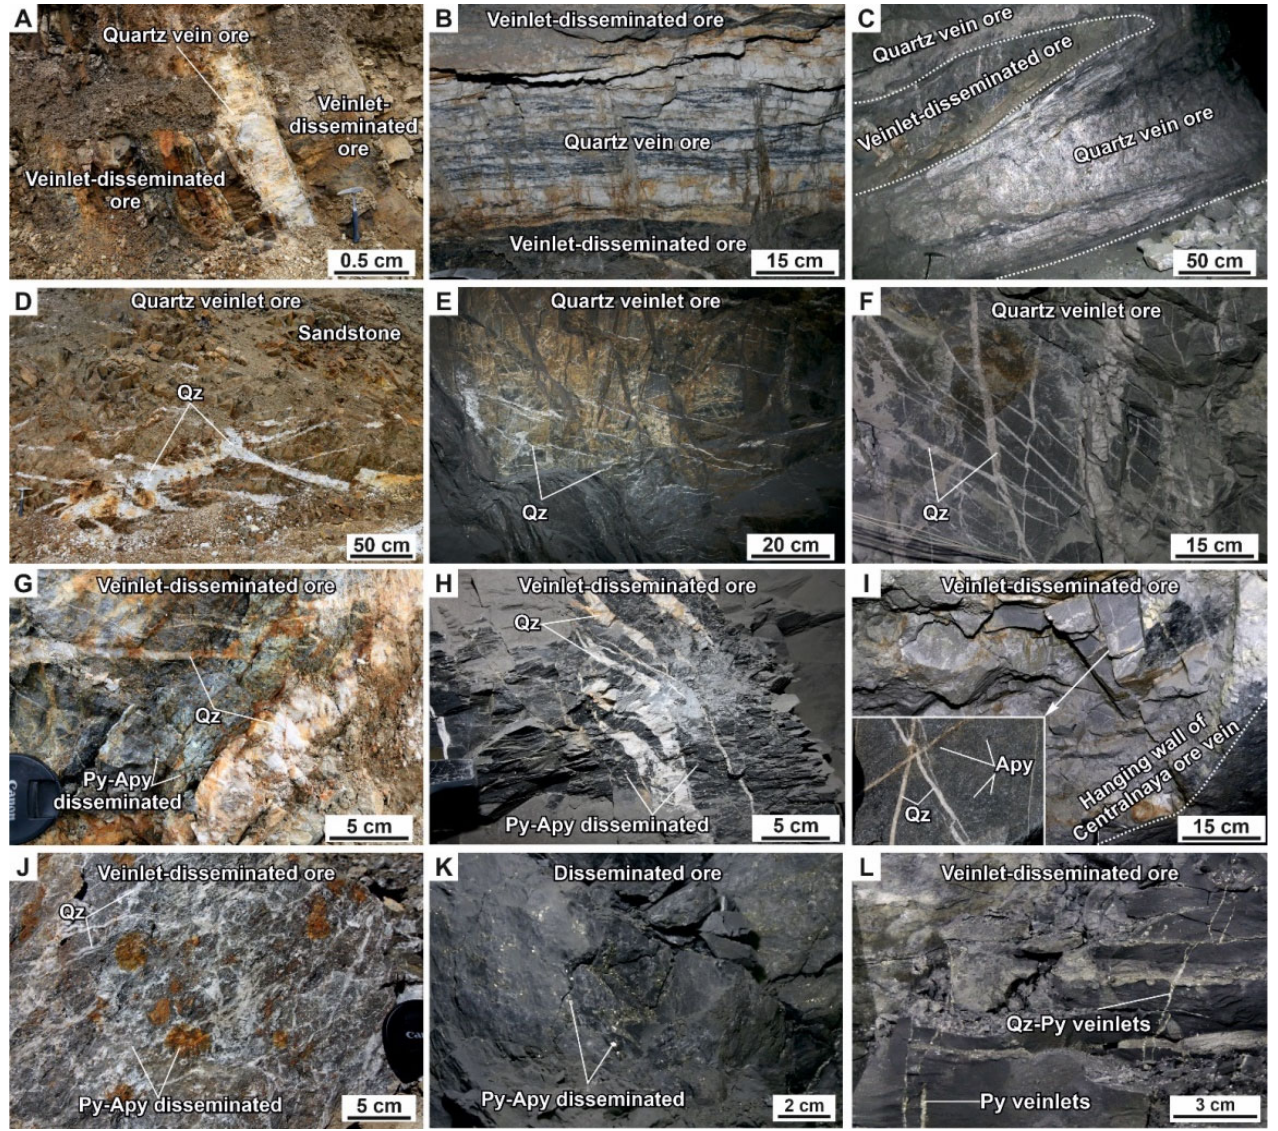
Figure 3. Ore bodies of ( A , D , G , J ) Malo–Taryn; ( B , E , H , K ) Badran; and ( C , F , I , L ) Khangalas orogenic gold deposits: ( A – C ) veins; ( D – F ) veinlets; ( G – J , I , L ) veinlet ‐ disseminated; ( K ) disseminated. Abbreviations: Qz—quartz, Py—pyrite, Apy—arsenopyrite.